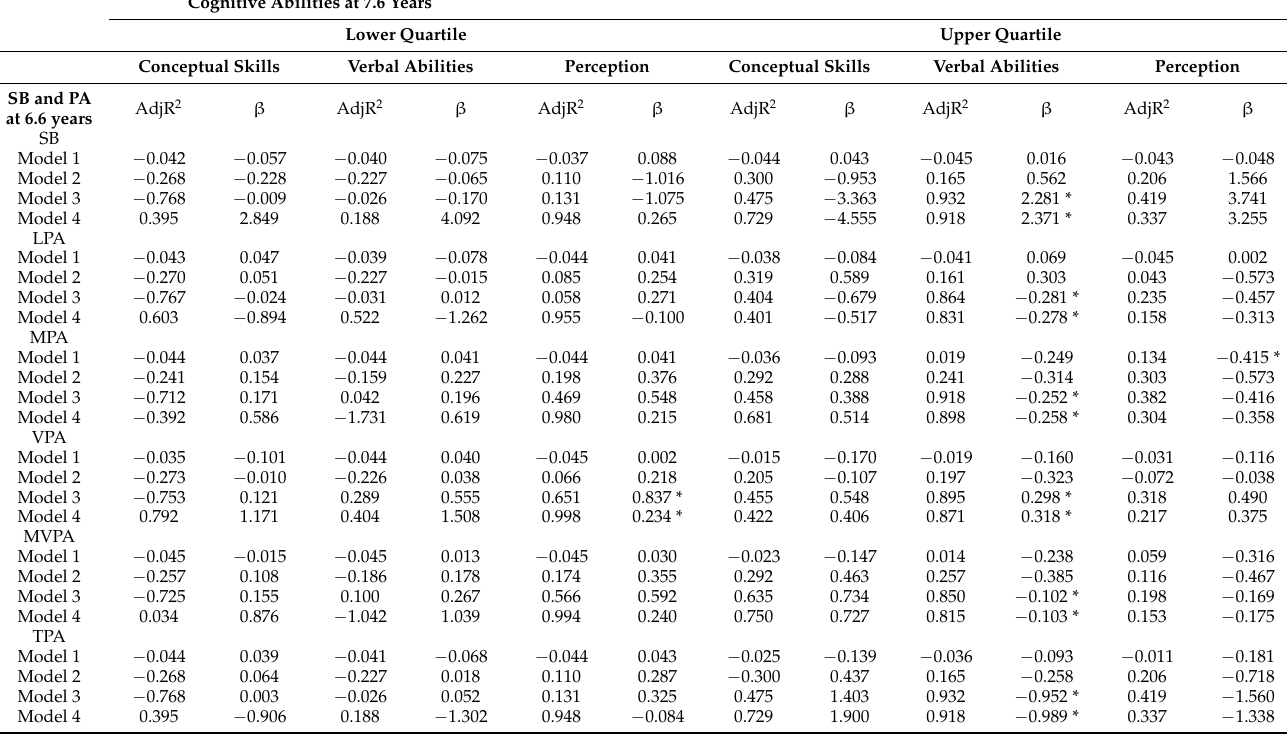
Table 2. Associations of sedentary behavior and physical activity intensities at 6.6 years (final year of kindergarten) with cognitive abilities at 7.6 years (1st grade at school) in kindergarten MVPA-based children of lower (25%) and upper (75%)